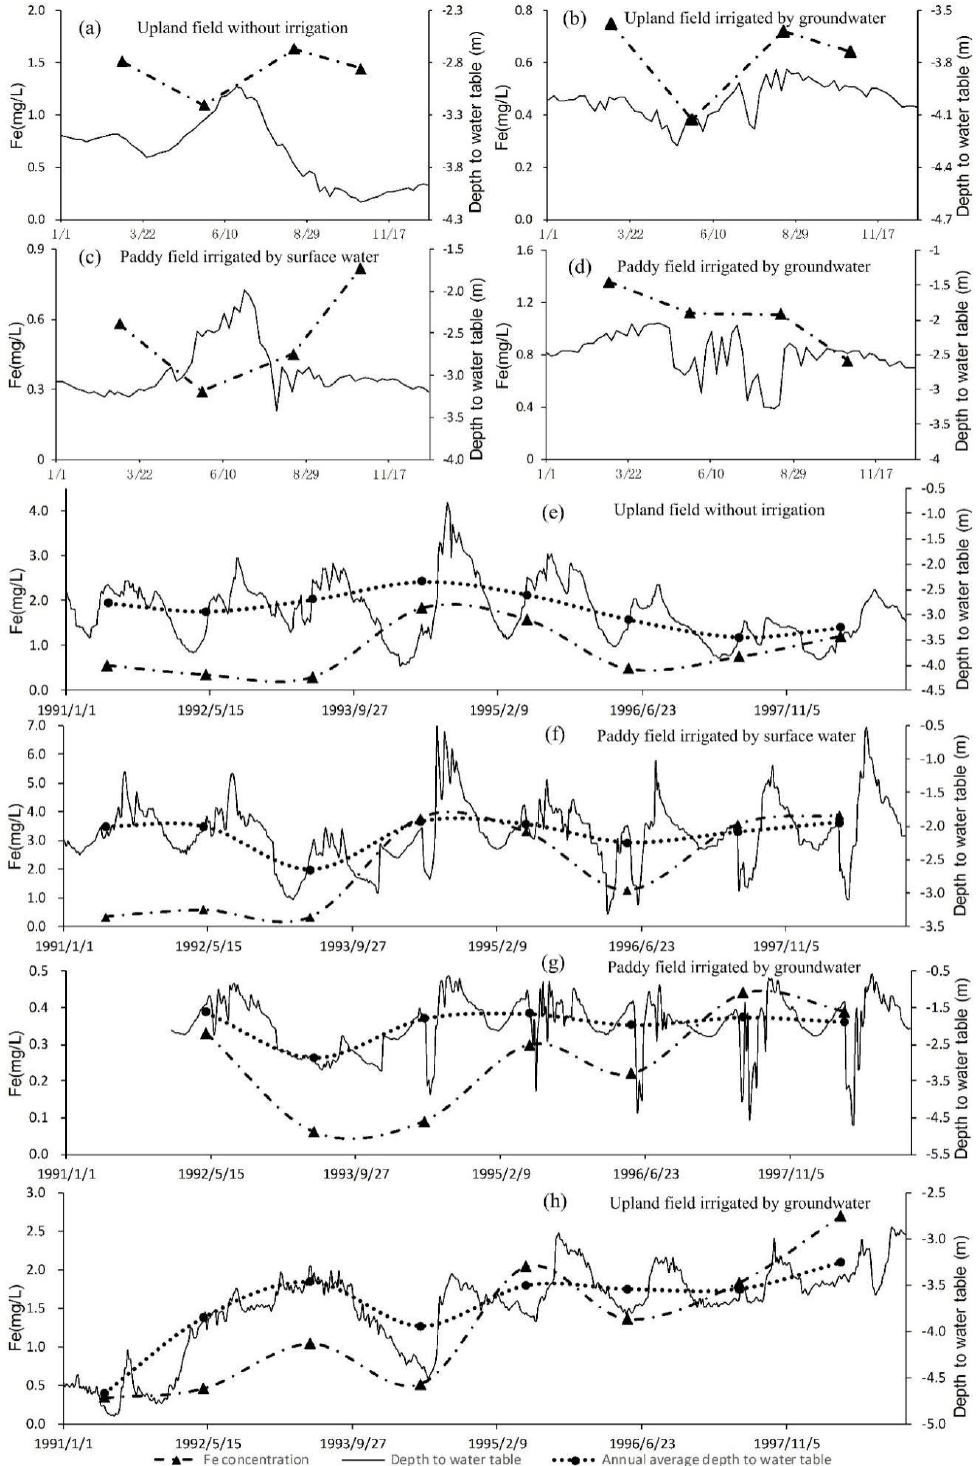
Figure 6. The relationship between depth to water table and iron concentration in di ff erent groundwater dynamic types.